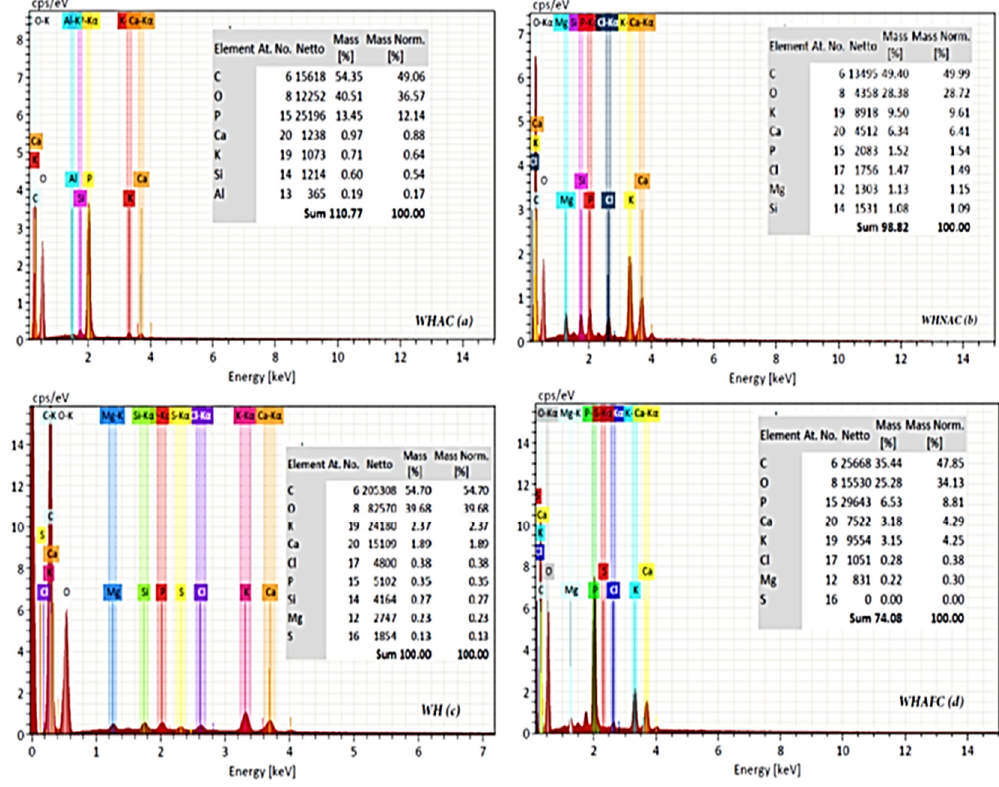
Figure 3. EDXA (energy dispersive X-ray analysis) diffractograms.